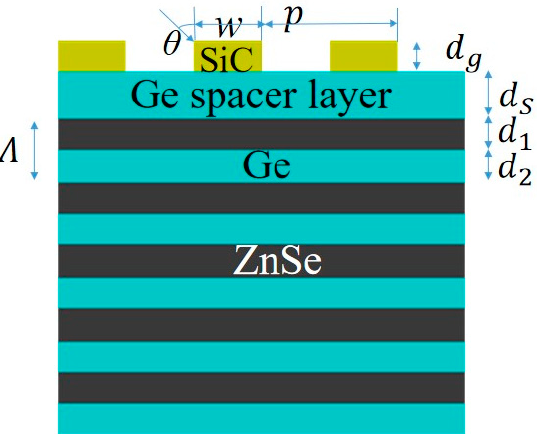
Figure 7. Cross-section view of the thermal emitter based on SiC grating with DBR reflector. Variations of the structural parameters will affect the spectra characteristics of the resonance. Figure 8a displays the calculated results through varying the grating period ( p ) between 1.5 and 2.5 μ m, with filling factor f = 0.5, and the grating height ( d g ) = 700 nm. The other parameters are the same as used in Figure 2. It is clearly that the maximum emissivity can be achieved with p = 2 μ m, when it is in resonance. As p increases further, the grating produces plane waves propagating at the interface, and the interference pattern produced by the plane waves produces a maximum in the field superimposed on the grating structure. This produces a Joule effect, increasing losses and thus leading to a reduction in emissivity. The similar effects have been observed on the change of f and d g , as illustrated in Figure 8b,c.